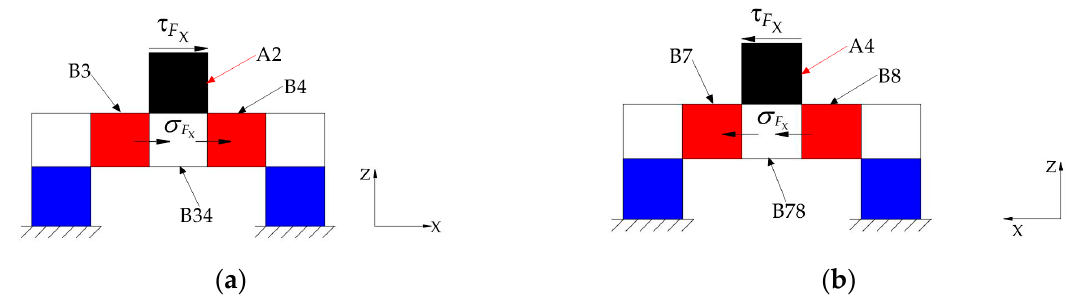
Figure 15. The stress in layer B induced by F X : ( a ) the stress transmitted to B34 by A2; ( b ) the stress transmitted to B78 by A4.